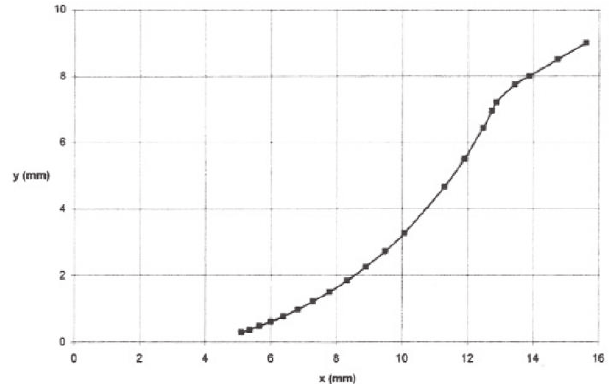
Figure 6A: The position of the needle (tracking the TN-point, equiv- alent to point 12 in Fig. 1) during the VP action for an initial injection angle situation, where θ 0 = 30 ◦ and length of the needle is 18 mm.